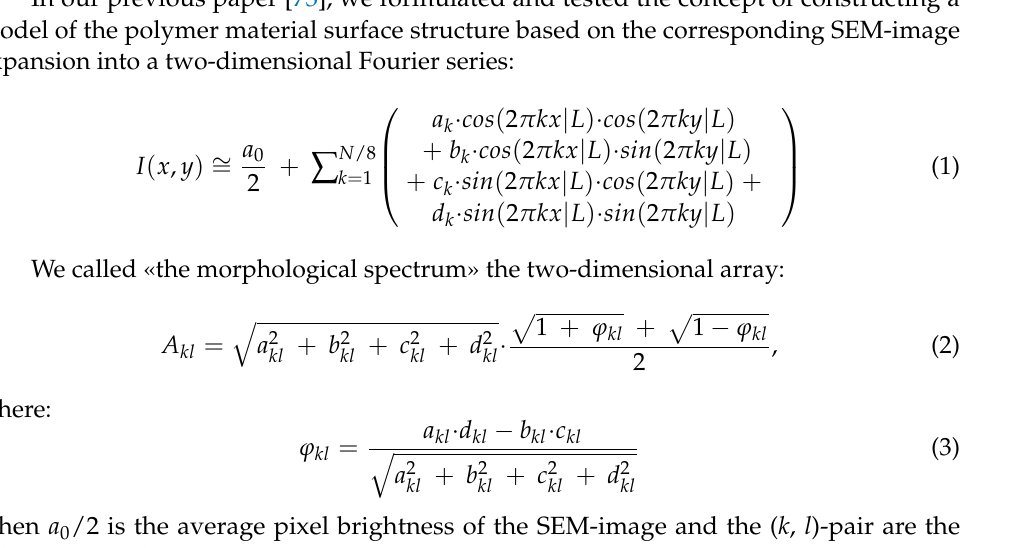
Figure 11. The SEM images at 10 k magnification of the original ( A ) and the modified ( B ) LDPE- substrates’ surfaces. substrates’